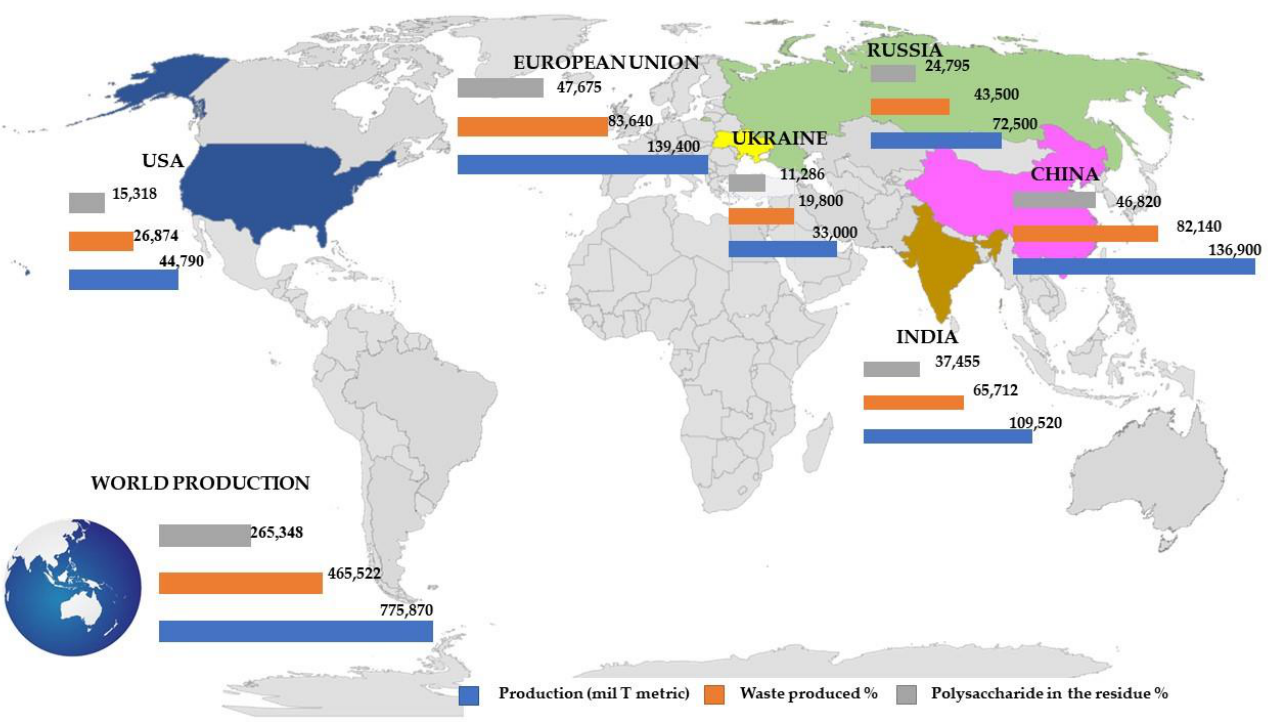
Figure 7. Main global producers of wheat in the year of 2020–2021: total production (in million metric tons, blue bars), waste production (orange bars), and estimated polysaccharide residues (gray bars).